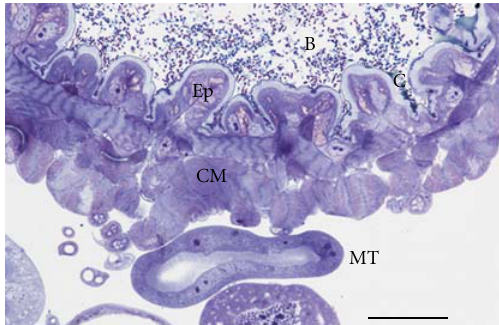
Figure 14: Insertion point (arrow) of a Malpighian tubule (MT) at the posterior end of the midgut (MG) just anterior of the pylorus (Py). Note the layer of cuticle (arrowheads) lining the pylorus, which is typical of the hindgut. Scale bar = 0.1 mm.